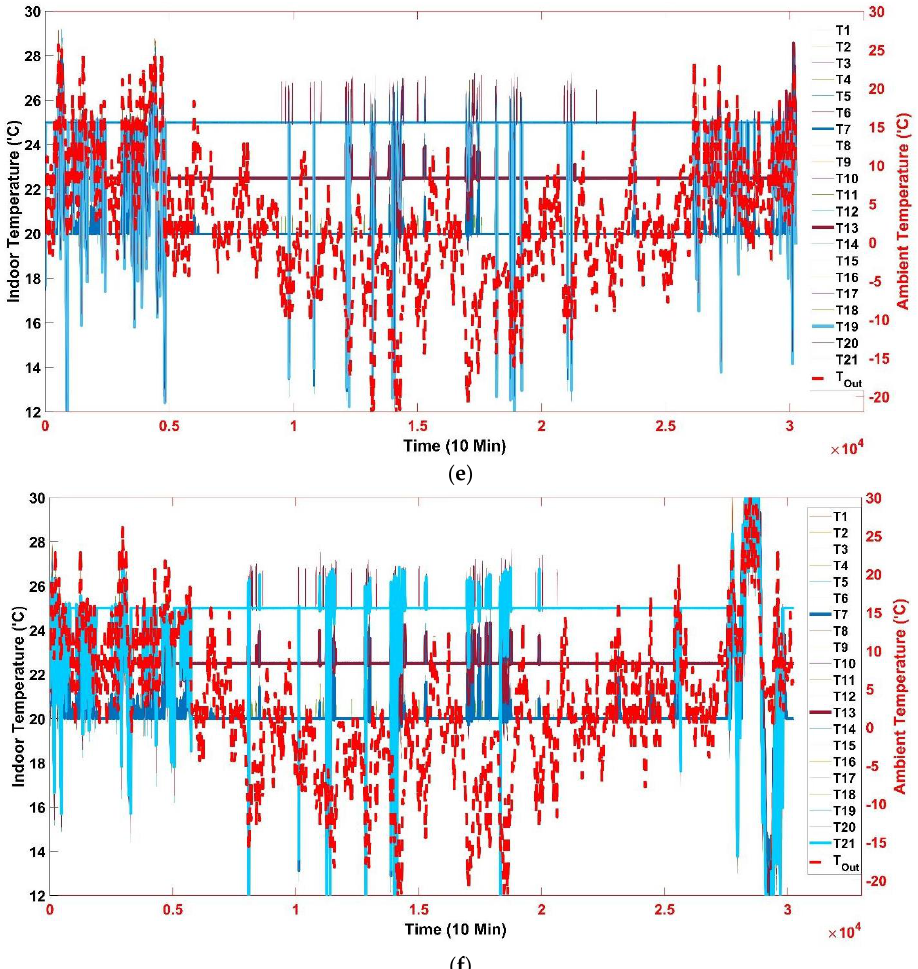
Figure 9. The building zone temperatures by applying controllers on the hydronic heating system (T1 to T21 represent building zone temperatures). ( a ) MPC-GA, ( b ) FLC, ( c ) OFSMC, ( d ) On/Off, ( e ) PID-GA, and ( f ) Fuzzy-PID.